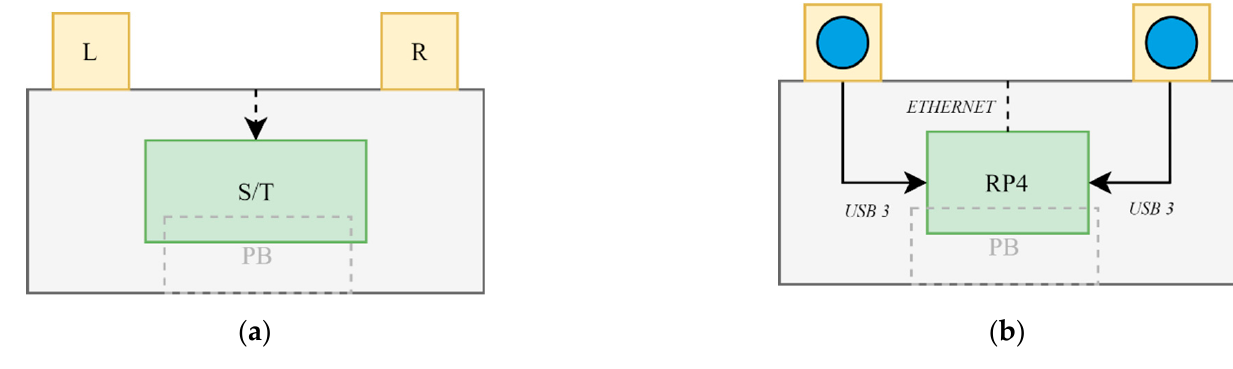
Figure 2. A sketch of the prototype. ( a ) Rear view: the operator can monitor the system output on a smartphone/tablet (S/T). ( b ) Front view: the Raspberry Pi 4B (RP4) is connected with USB3 to the cameras (L, R) and with Ethernet to the smartphone/tablet (S/T). The power bank (PB) is placed inside the body frame.